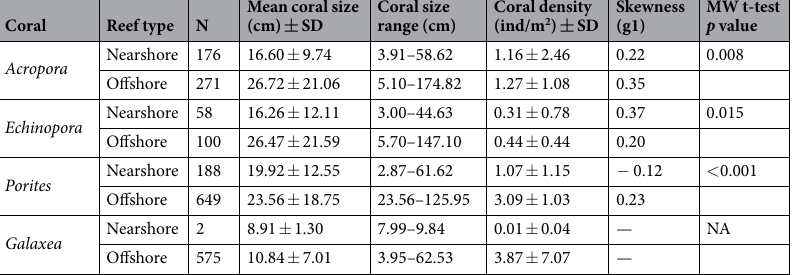
Table 4. Coral abundance, size and density and skewness distribution for the four most abundant genera at the Farasan Islands, Southern Red Sea. SD, Standard Deviation. Statistical differences between nearshore versus offshore reefs using the Mann-Whitney (MW) t-test for the most abundant genera.